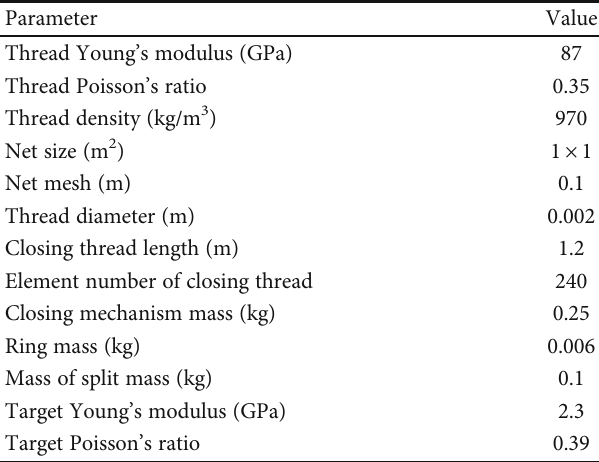
Table 4: Simulation parameters.